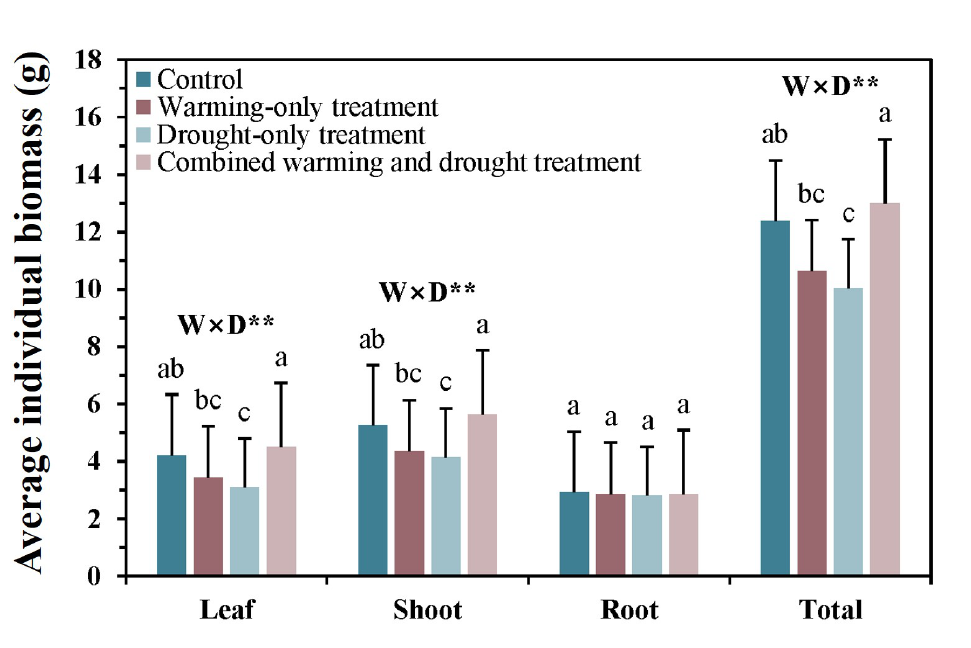
Figure 4. Average individual biomass of Larix kaempferi seedlings as influenced by warming and drought treatments in November 2020. Bars with different letters are significantly different among treatments at p < 0.05. Error bars are the standard errors of the means, and asterisks (*) indicate significant differences between the warming and drought treatments (** p < 0.01). W: warming effect; D: drought effect; W × D: interaction effect of warming and drought.